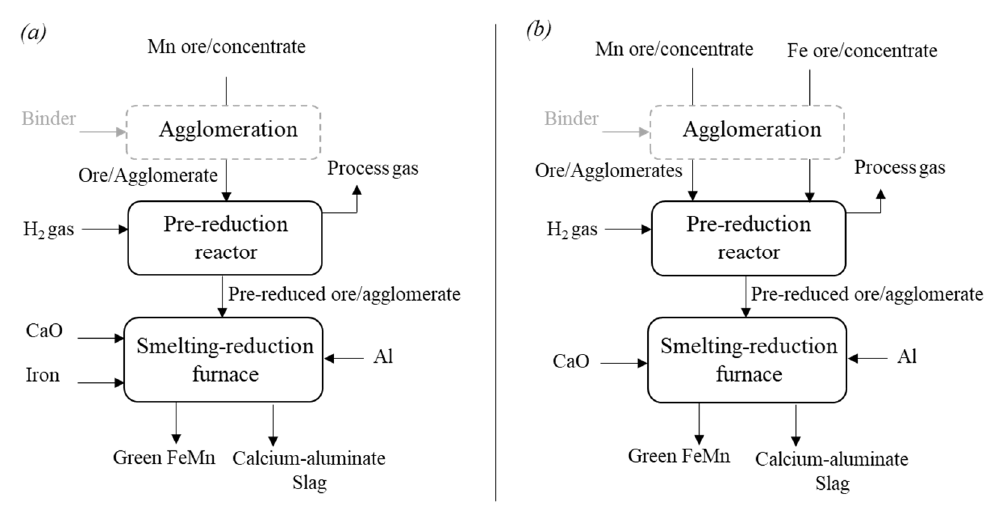
Figure 6. Material flow sketch to produce Green FeMn via the use of iron ( a ) or iron ore/concentrate ( b ).